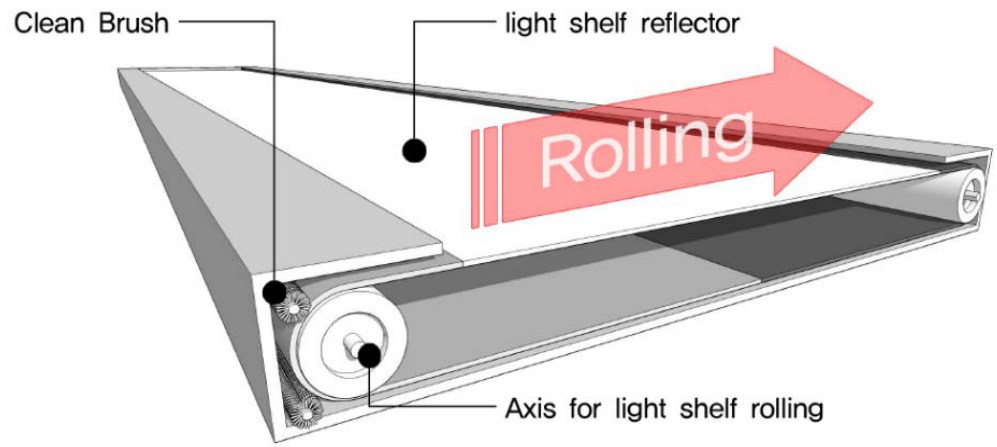
Figure 13. Maintenance of reflector through reflector rolling (application of clean brush system).